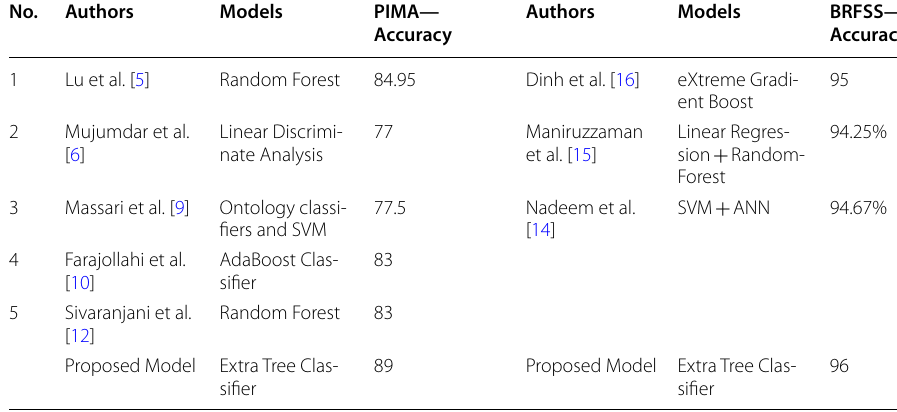
Table 4 Comparison with the state of the art for PIMA and BRFSS datasets